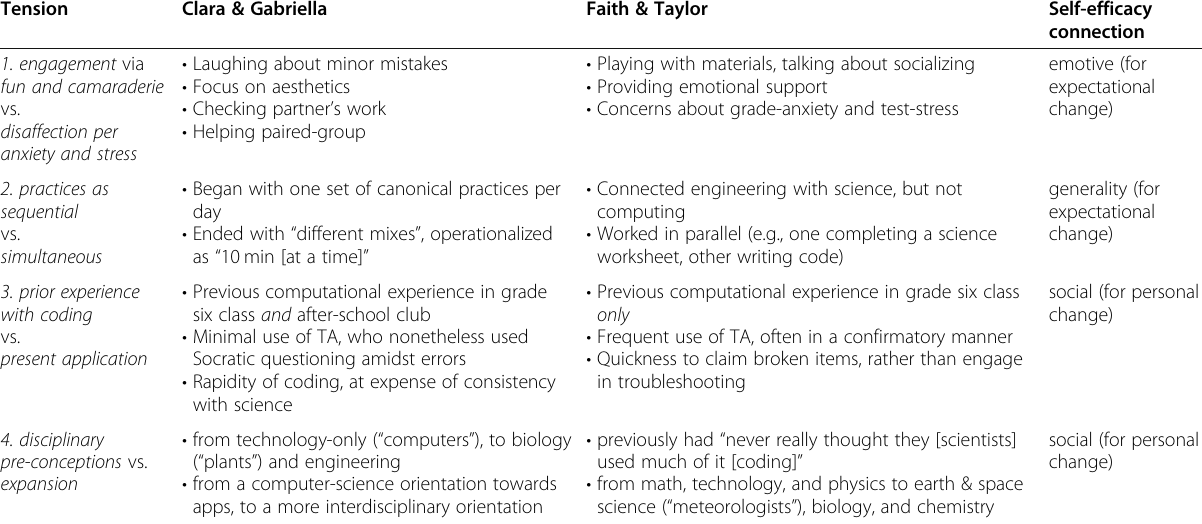
Table 6 Tensions in student practices, from variable- and case-based analyses Tension